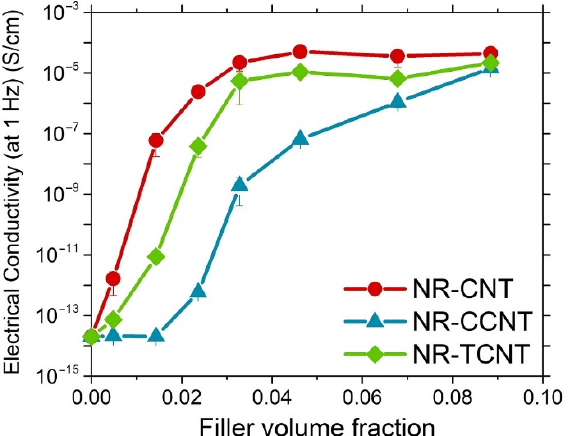
Figure 11. Variation of the electrical conductivity with the CNT content in natural rubber (NR) compounds.